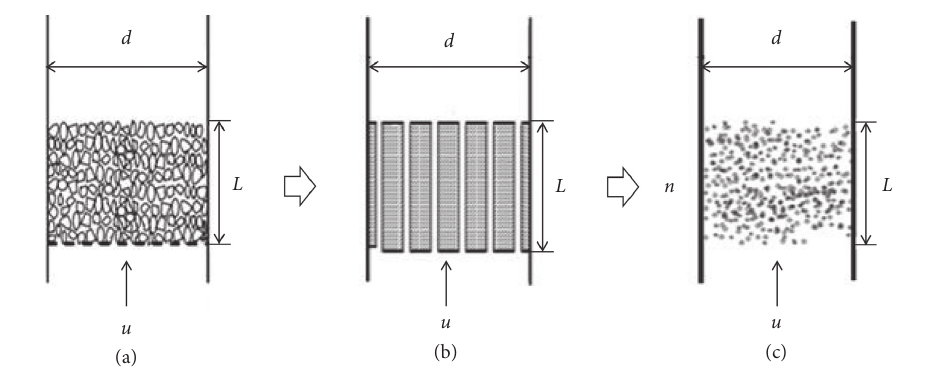
Figure 1: Schematic diagram of the tar mist and dust movement.